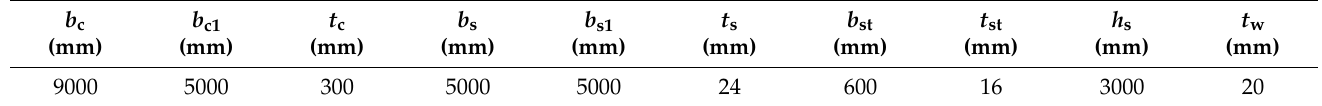
Table 1. Cross-section of a simply supported composite beam (validation through instantaneous analysis).